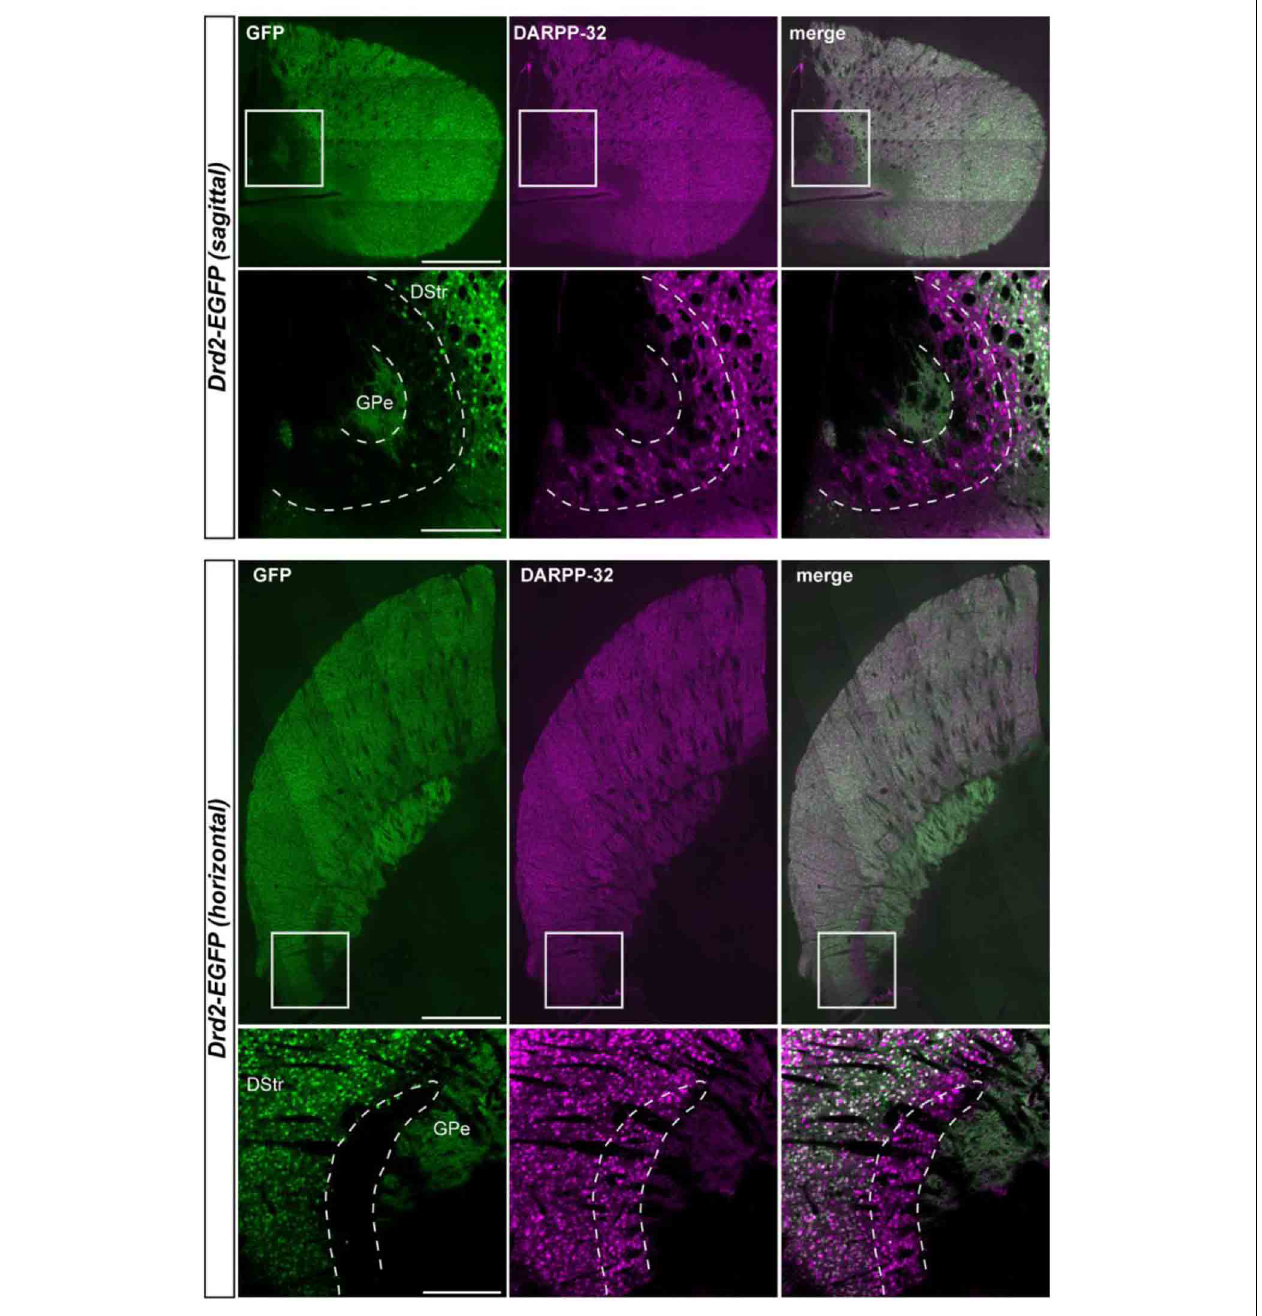
FIGURE A1 | Whole-striatum anatomical characterization of the D2R/A2aR-expressing MSNs-poor zone of the caudal striatum. Sagittal (upper panel) and parahorizontal (lower panel) view of the striatum of Drd2-EGFP mice immunostained for DARPP-32 (magenta).